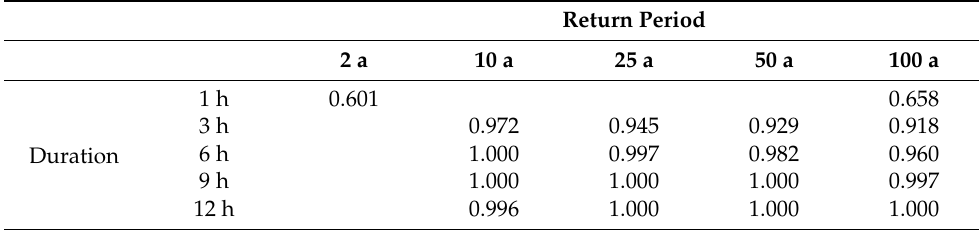
Table 4. Corresponding coefficients of determination R2 (-) for the simulated rain events.